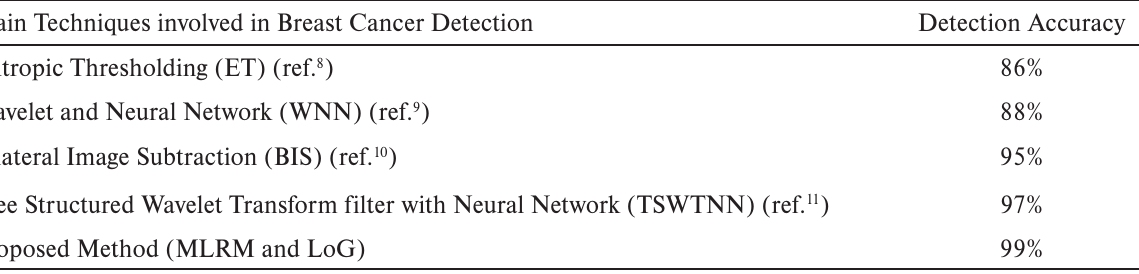
Table 2. Detection Accuracy comparison of proposed method with the existing